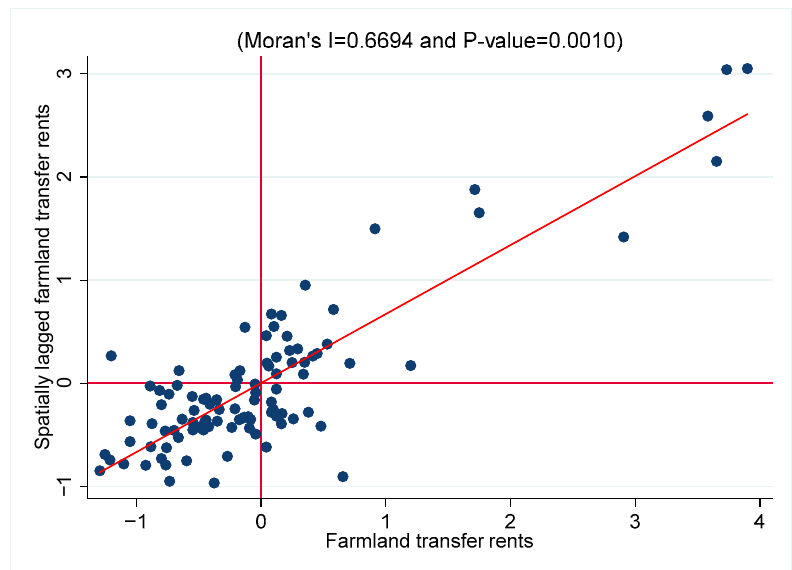
Figure 4. Moran scatter plot of farmland transfer rents.